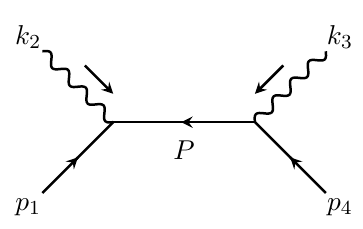
Figure 3. Generic A 3 × A 3 gluing configuration with all edges